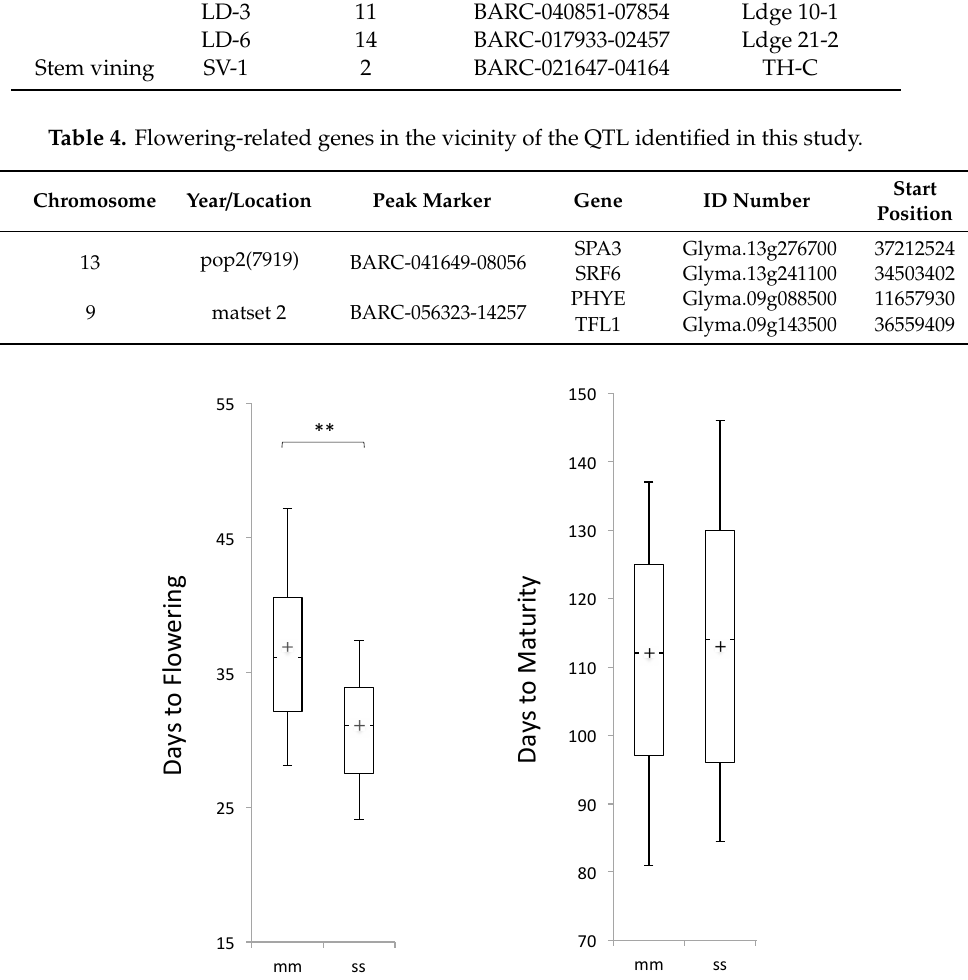
Table 3. Previously reported QTL (http://soybase.org/) that overlap with the QTL identified in this study.